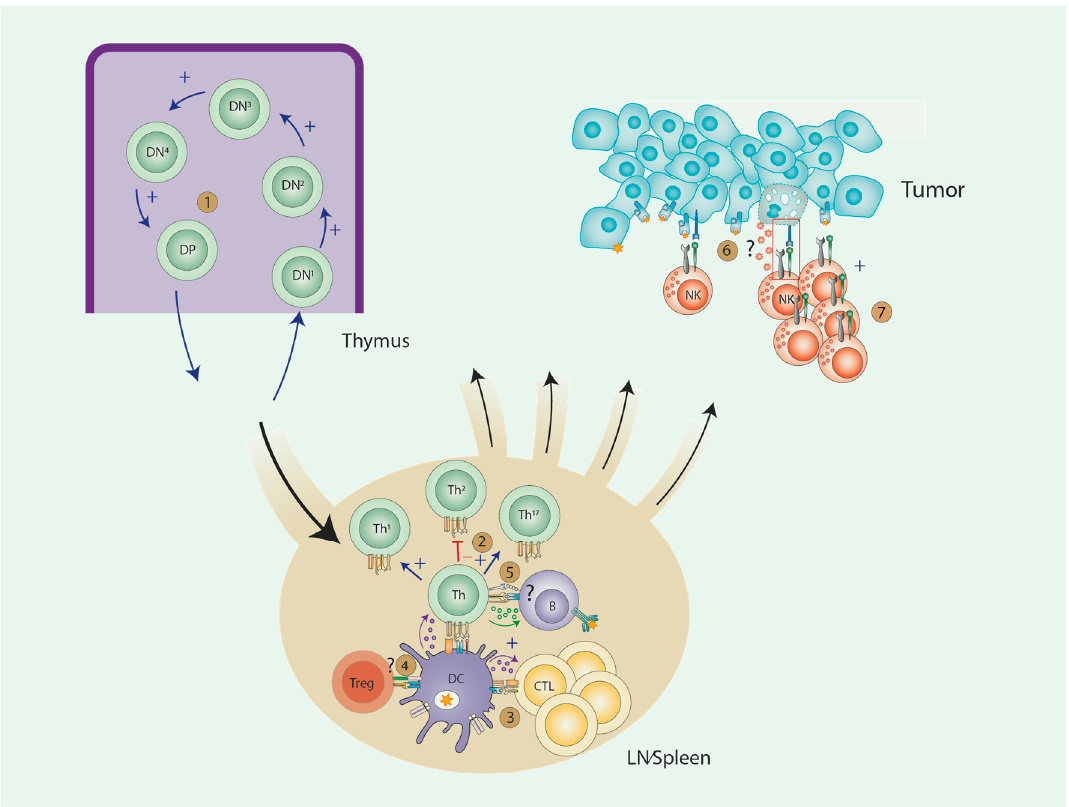
Figure 1. Effects of AA on Immune cells. 1 . T cell development: Enhanced T cell development due to fast transition from DN to DD stage. 2 . Th cell differentiation: skewing towards Th1 and Th17, with inhibition of Th2 polarization. 3 . CTL induction: Increased induction of CTLs due to production of IL-15 and IL-12 by DCs. 4 . Treg induction: Current data are conflicting. 5 . B cell: No conclusive data. 6 . NK cell function: No conclusive data. 7 . NK cell proliferation: increased NK cell